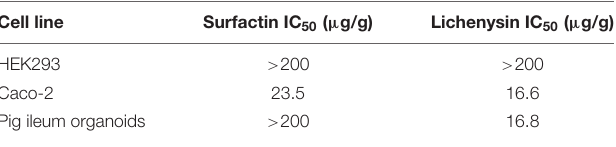
TABLE 3 | Cytotoxic level of lichenysin and surfactin (IC 50 ) to human and mammalian